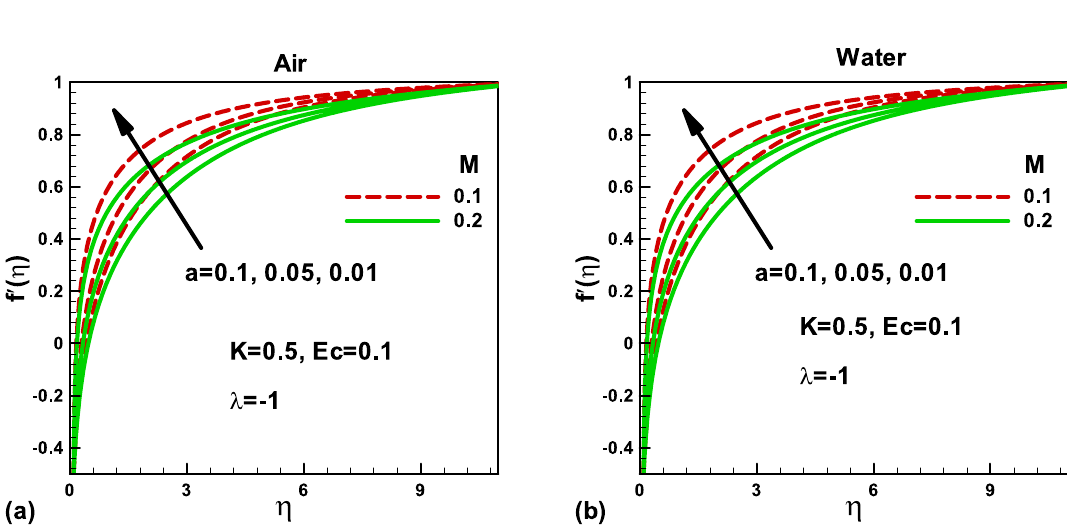
Figure 2. Effects of the magnetic parameter on dimensionless velocity for (a) and (b) when the free stream is moving in the positive x-axis and the needle is moving in the opposite